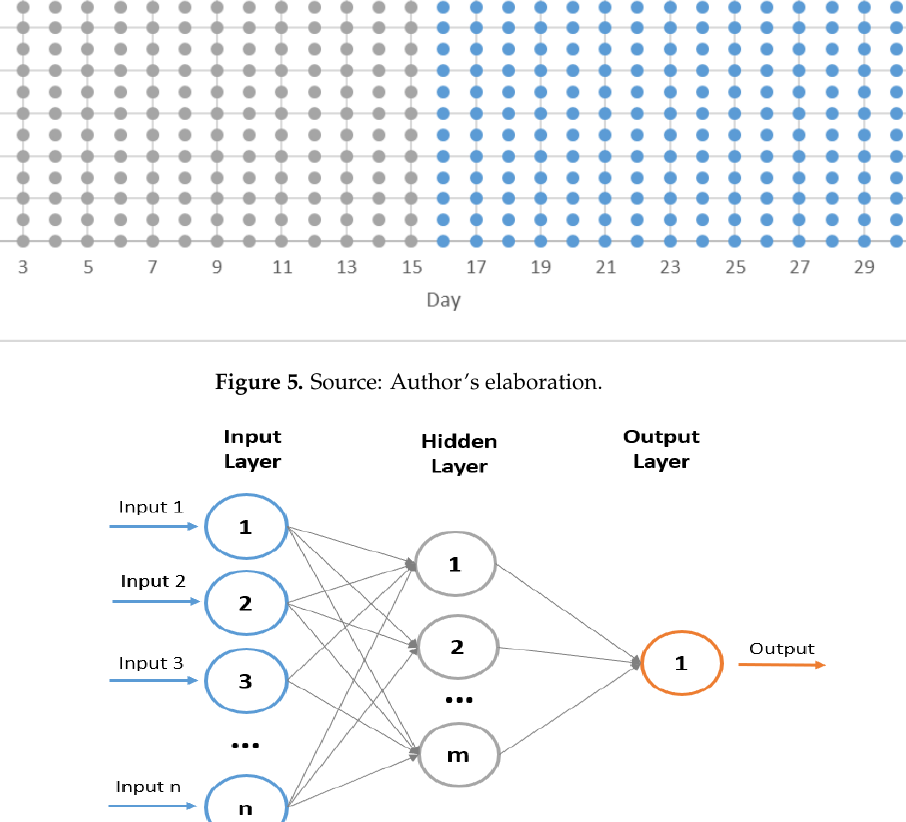
Figure 6. Source: Multilayer neural network diagram. Own elaboration.